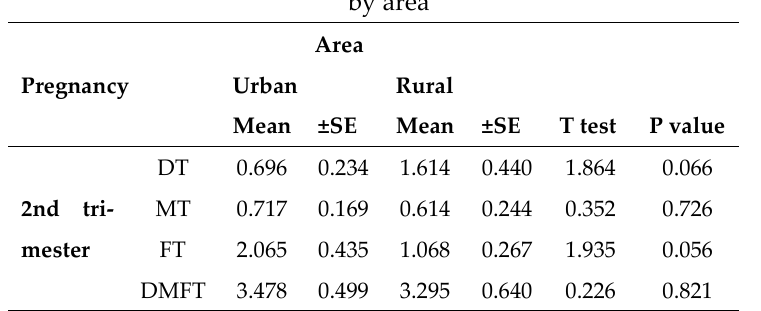
Table 4: Descriptive and statistical tests of dental caries experience (DMFT) among pregnant women by area